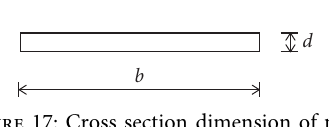
Figure 17: Cross section dimension of plate.